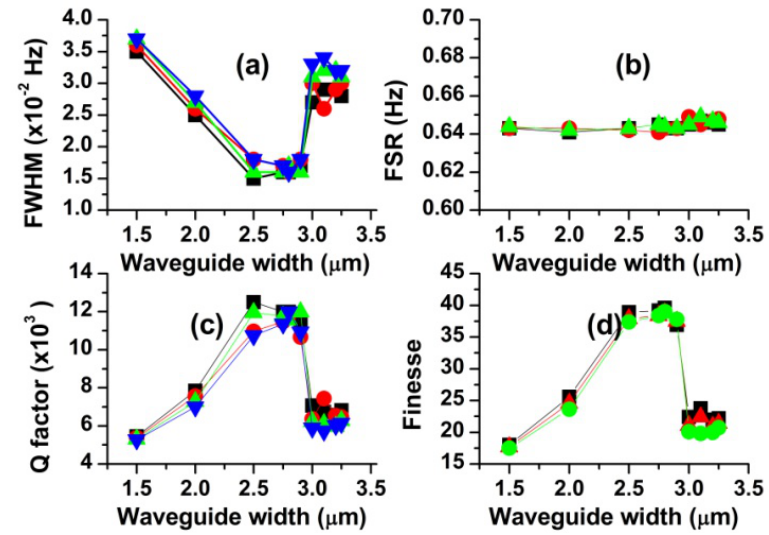
Figure 7. Effects of the waveguide width on the resonance characteristics (d = 100 μ m, t = 3 μ m, g = 0 μ m). Displayed four data sets are obtained from adjacent resonance peaks, respectively.